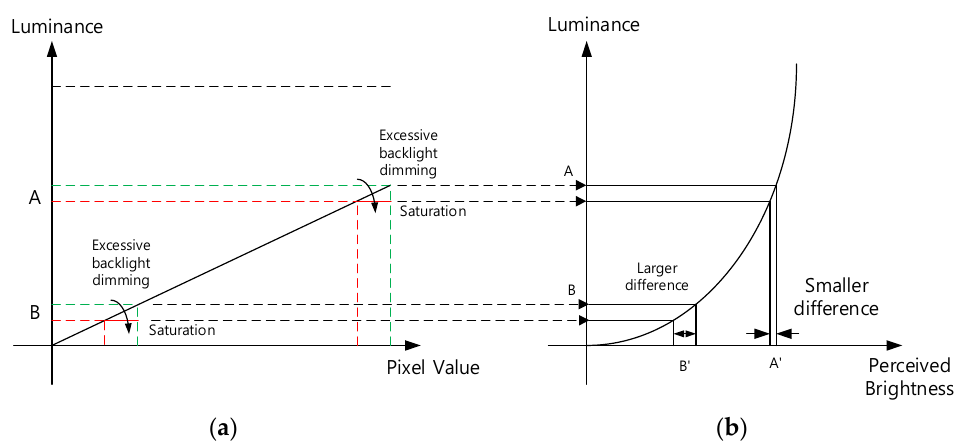
Figure 3. Brightness sensitivity. ( a ) Pixel value vs. Luminance; ( b ) Brightness sensitivity.